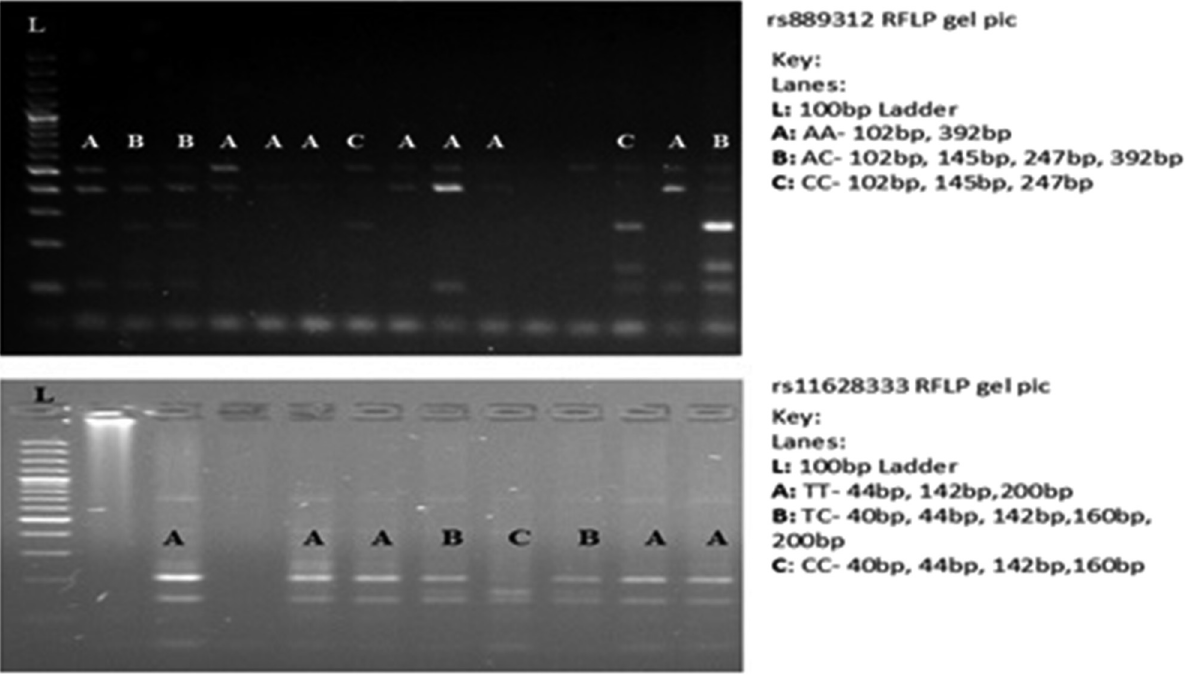
Figure 1: Digested PCR products for the